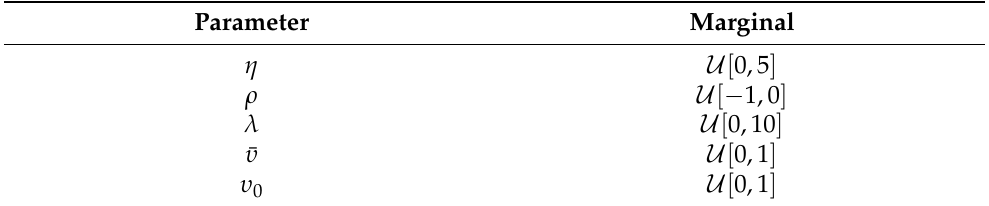
Table 1. Marginal priors of the model parameters µ for synthetically generating D . The interest rate r is